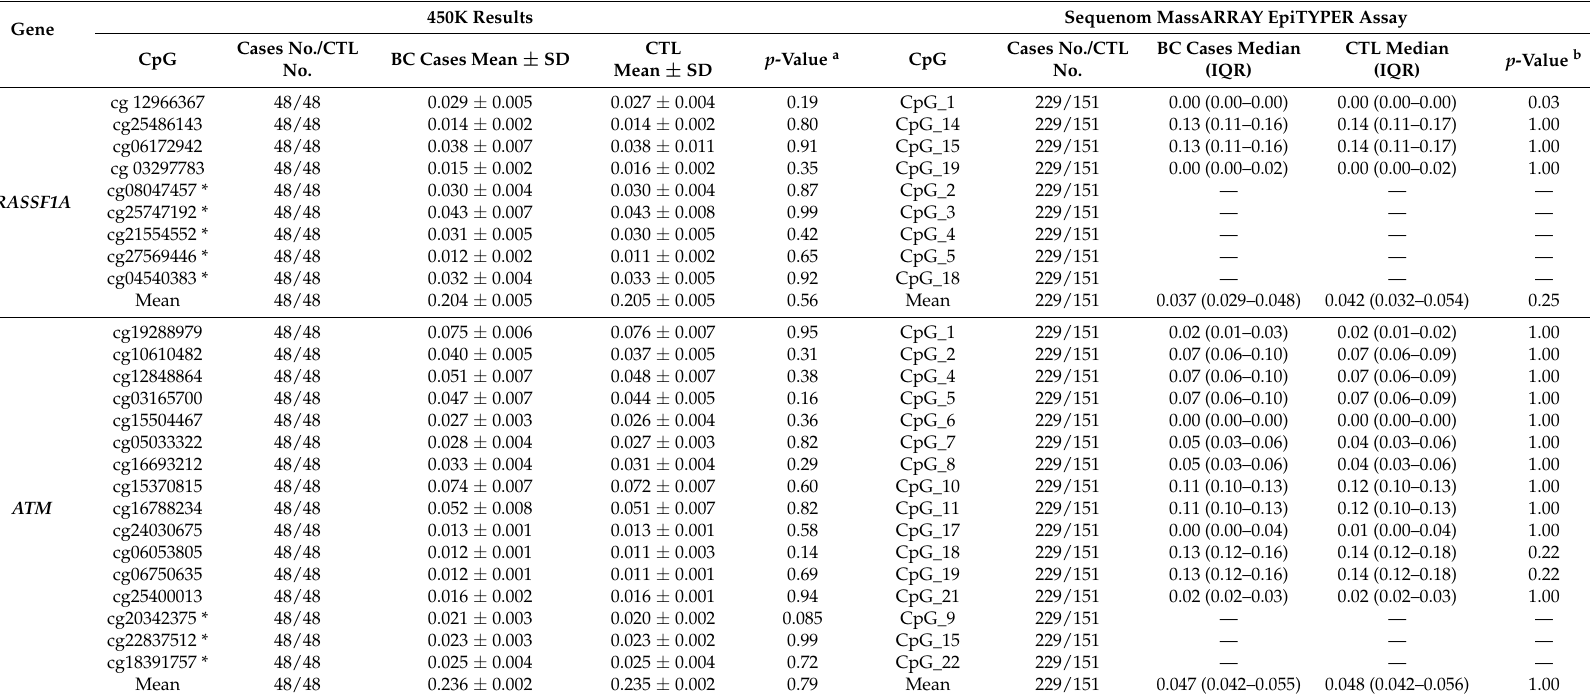
Table 4. Comparison of methylation levels of peripheral blood DNA between different analytical